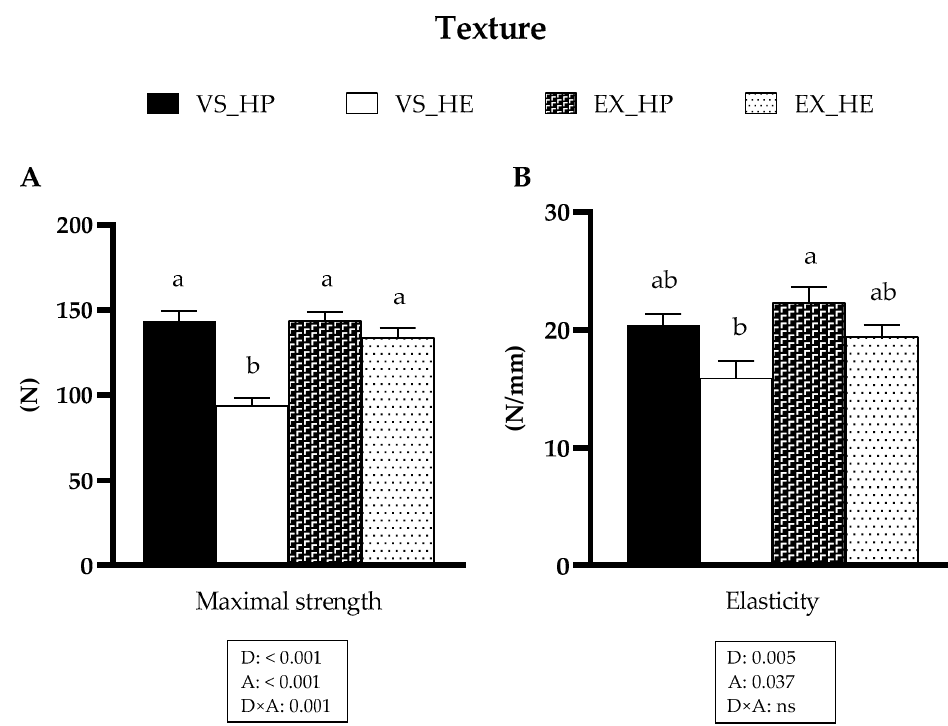
Figure 10. Muscle maximal strength ( A ) and elasticity ( B ) of fish under voluntary swimming (VS) or sustained exercise (EX) and fed with high protein diet (HP) or high-energy diet (HE). Data are shown as means + SEM. VS, n = 10; EX, n = 16. Factorial statistical analysis was assessed by two-way ANOVA, and p -values of factors diet (D), physical activity (A), and interaction (D×A) are displayed under graph. Different letters indicate significant differences (Tukey’s post-hoc test, p < 0.05).